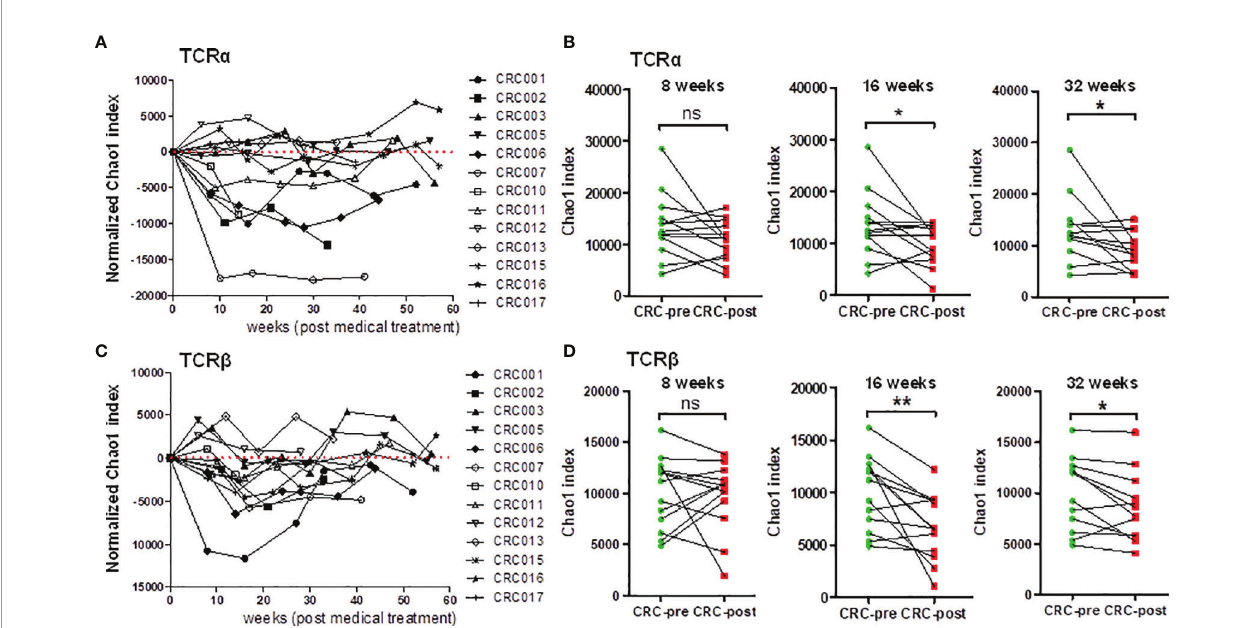
FIGURE 4 | Dynamic analysis of TCR a and TCR b repertoire diversity in follow-up CRC patients who underwent chemotherapy. (A) The normalized TCR a Chao1 index from a total of 80 samples, including 13 CRC-pre samples (CRC001 to CRC017) and 67 follow-up CRC-post samples, was used to analyze and normalize to the value of paired baseline CRC-pre samples. The normalized Chao1 index (y-axis) and sample collection time (x-axis; weeks) were used to plot the connected scatterplot. (B) TCR a Chao1 index at the indicated time points (8 weeks, 16 weeks, and 32 weeks) in follow-up CRC-post (red squares) subjects and paired CRC- pre (green circles) subjects were compared. (C) The normalized TCR b Chao1 index from 80 samples was determined and analyzed as described in panel (A) . (D) The TCR b Chao1 index results at the indicated time points (8 weeks, 16 weeks, and 32 weeks) in follow-up CRC-post (red squares) subjects and paired CRC- pre (green circles) subjects were compared. Statistical signi fi cance was determined using paired Student ’ s t-test. ns p > 0.05, *p < 0.05, **p <